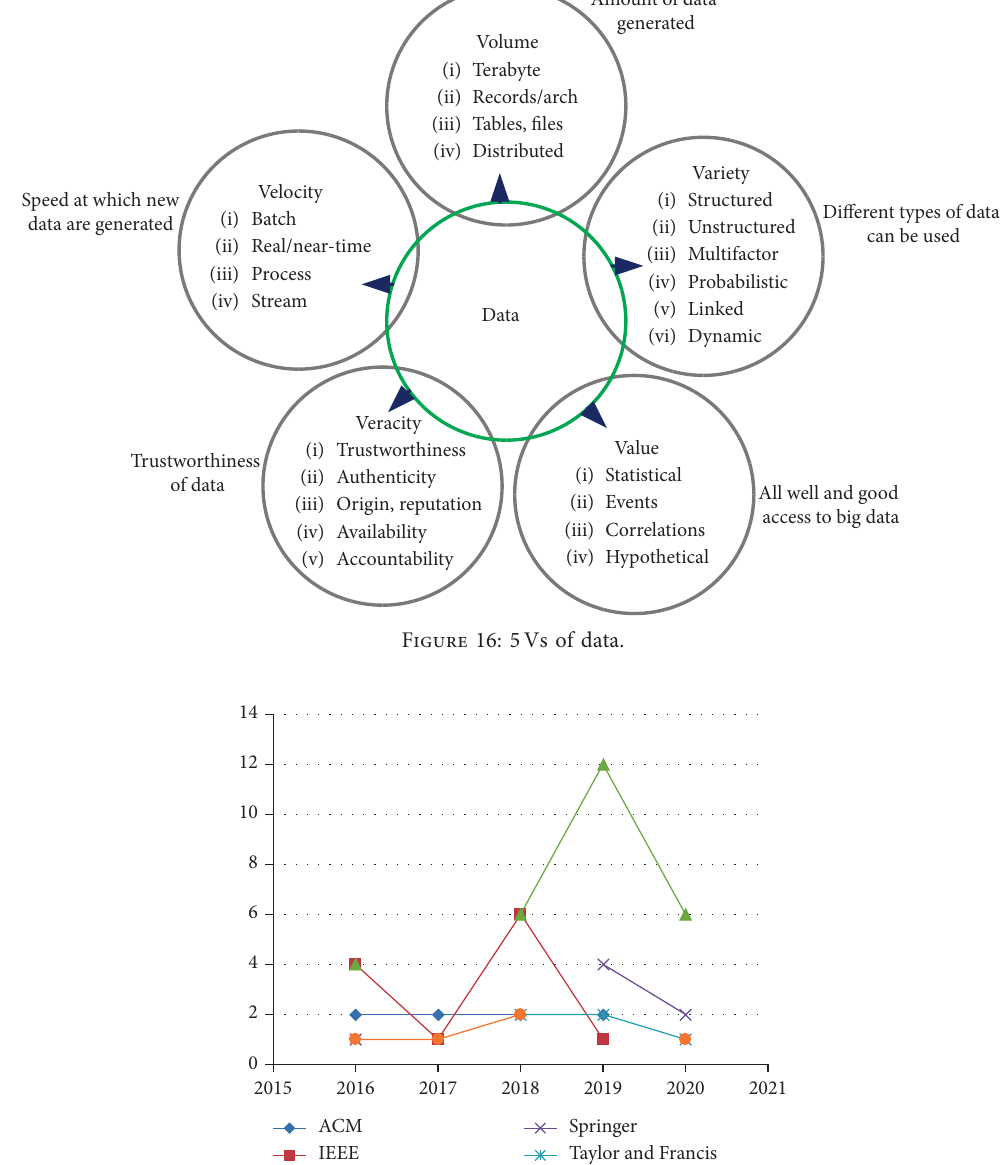
Figure 16: 5Vs of data.